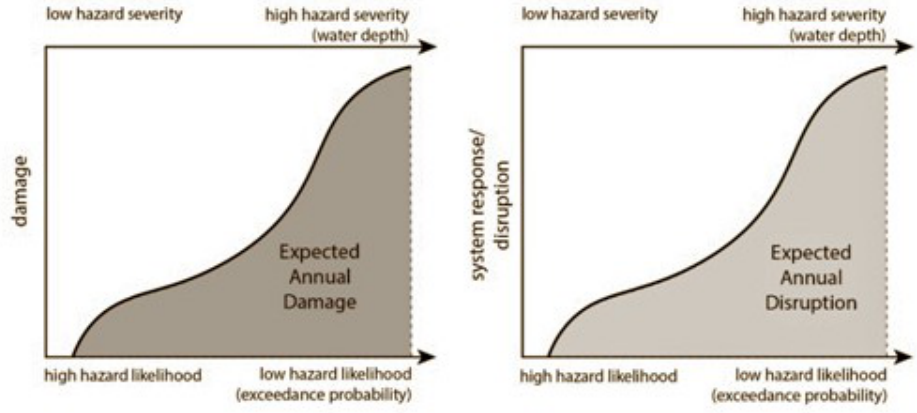
Fig. 3. Expected annual damage and expected annual